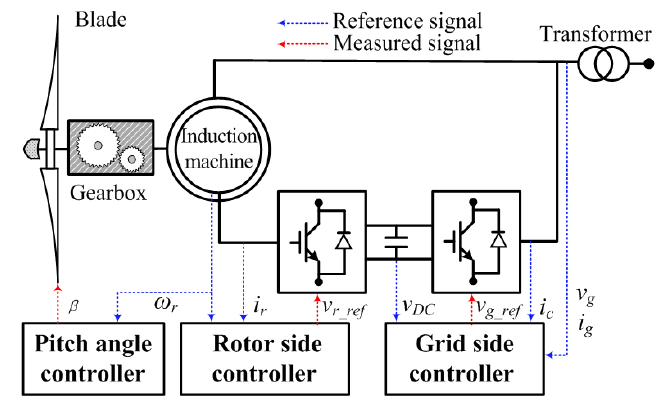
Figure 1. Configuration of the doubly-fed induction generator (DFIG)-based wind turbine generator (WTG).